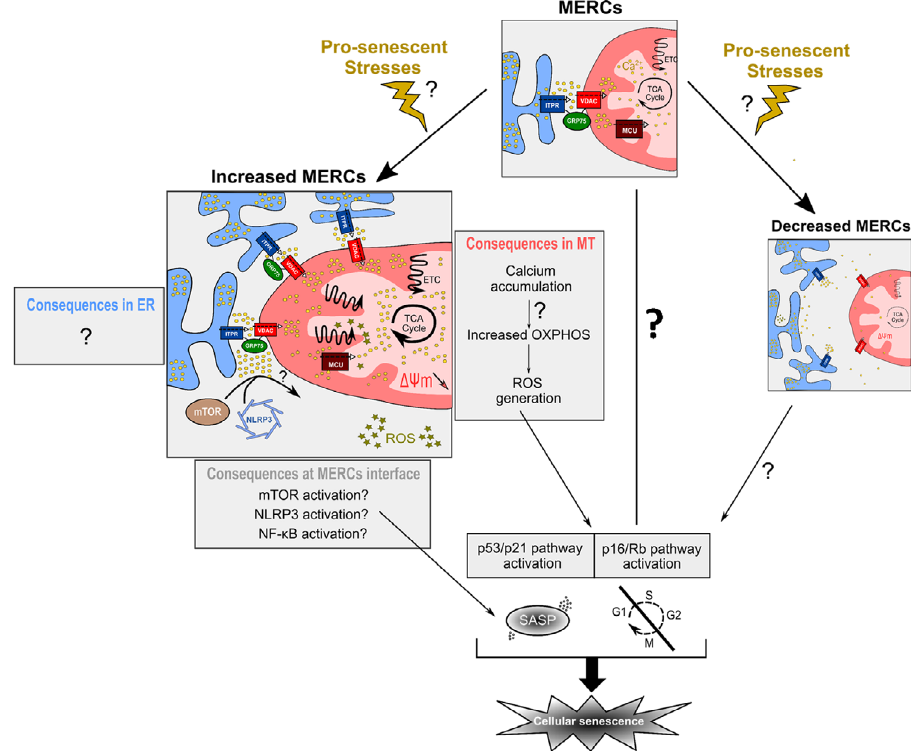
Fig. 3 Mechanistic working model of MERC-induced senescence. Under physiological stimuli, MERCs allow proper calcium transfer from ER (in blue) to mitochondria (MT, in red). Upon pro-senescent stresses or other stimulations, MERCs number could be modi fi ed. Increased MERCs number (left panel) leads to mitochondrial calcium accumulation, a potential increased oxidative phosphorylation (OXPHOS) and an increased production of ROS activating p53/p21 and p16/Rb pathways to mediate cell cycle arrest and Senescence-Associated Secretory Phenotype (SASP), driven partly by NF- κ B. In the meantime, whether increased MERCs would participate in ER-associated phenotypes, such as ER stress, is so far not known. In the cytosol-associated part, enhanced MERCs interface may activate three main SASP regulators, including mTOR, NLRP3 or NF- κ B subunits. Finally, whether decreased MERCs number (right panel) may regulate cellular senescence and what could be the associated mechanisms remain to be critically